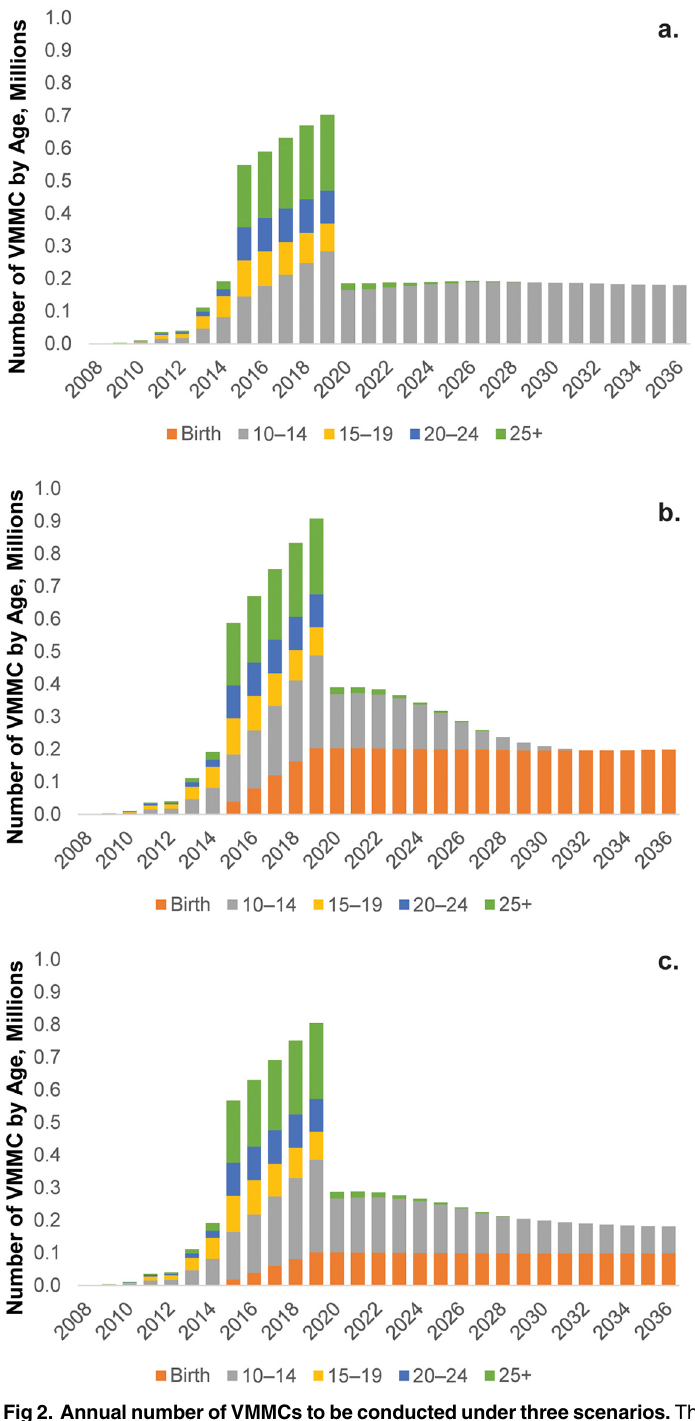
Fig 2. Annual number of VMMCs to be conducted under three scenarios. These scenarios are VMMC scaled up to (a) 80% coverage among 10- to 34-year-olds, (b) 80% coverage among 10- to 34-year-olds + 80% EIMC, (c) 80% coverage among 10- to 34-year-olds + 40% EIMC.